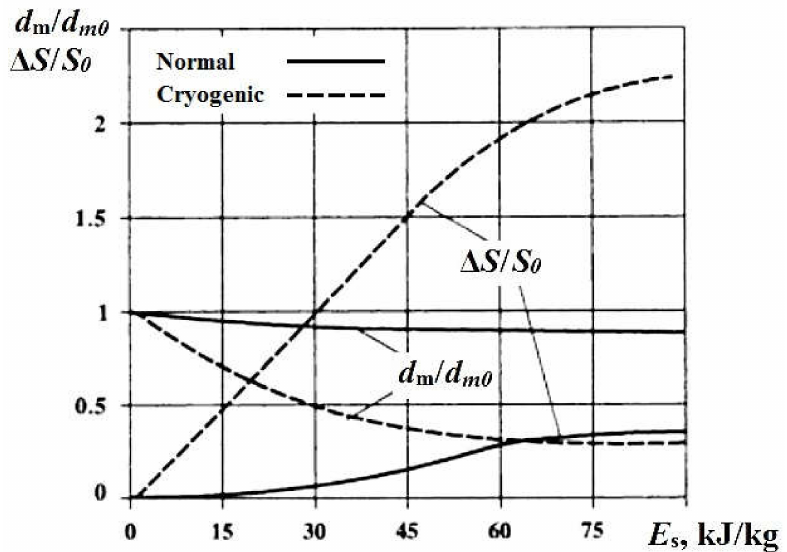
Figure 12. Dependence of ratio of median size to initial value d m / d m 0 on specific energy of treatment ( E S ) at normal and cryogenic